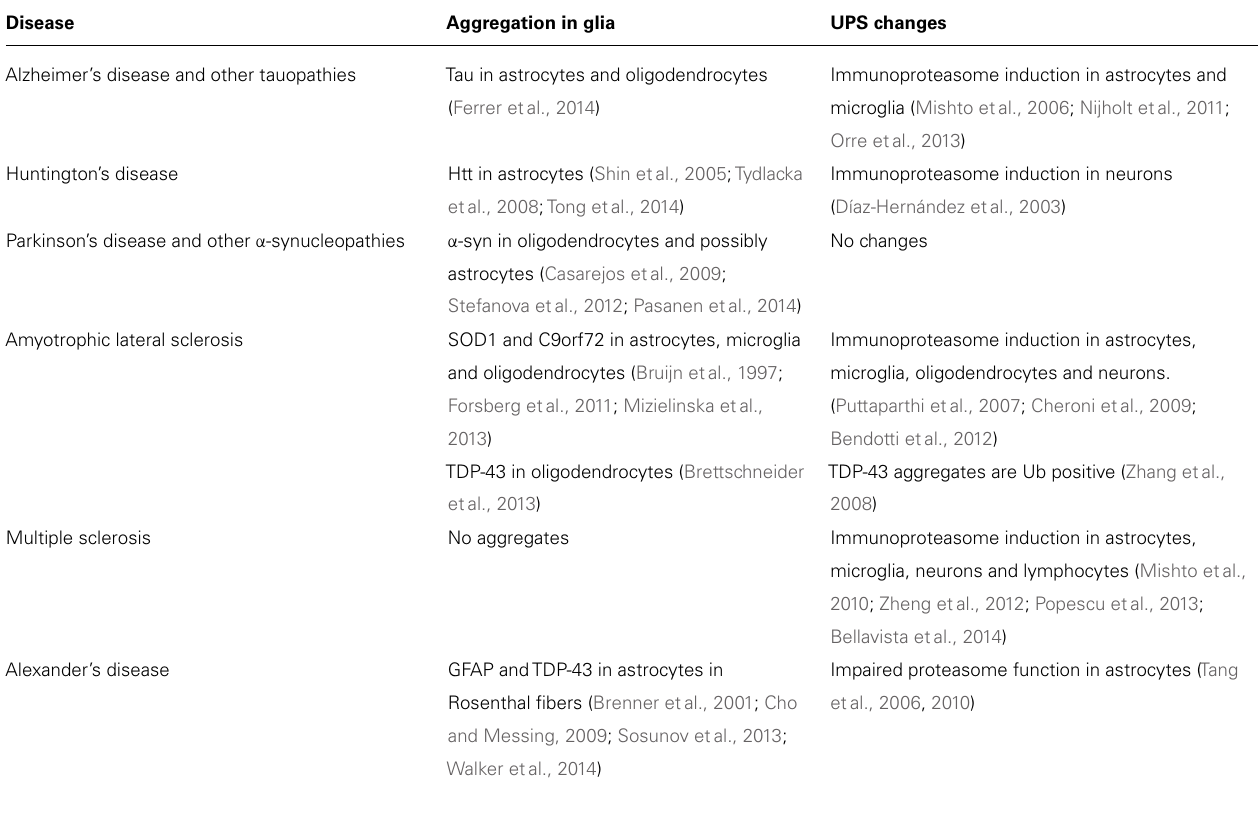
Disease Aggregation in glia UPS changes Alzheimer’s disease and other